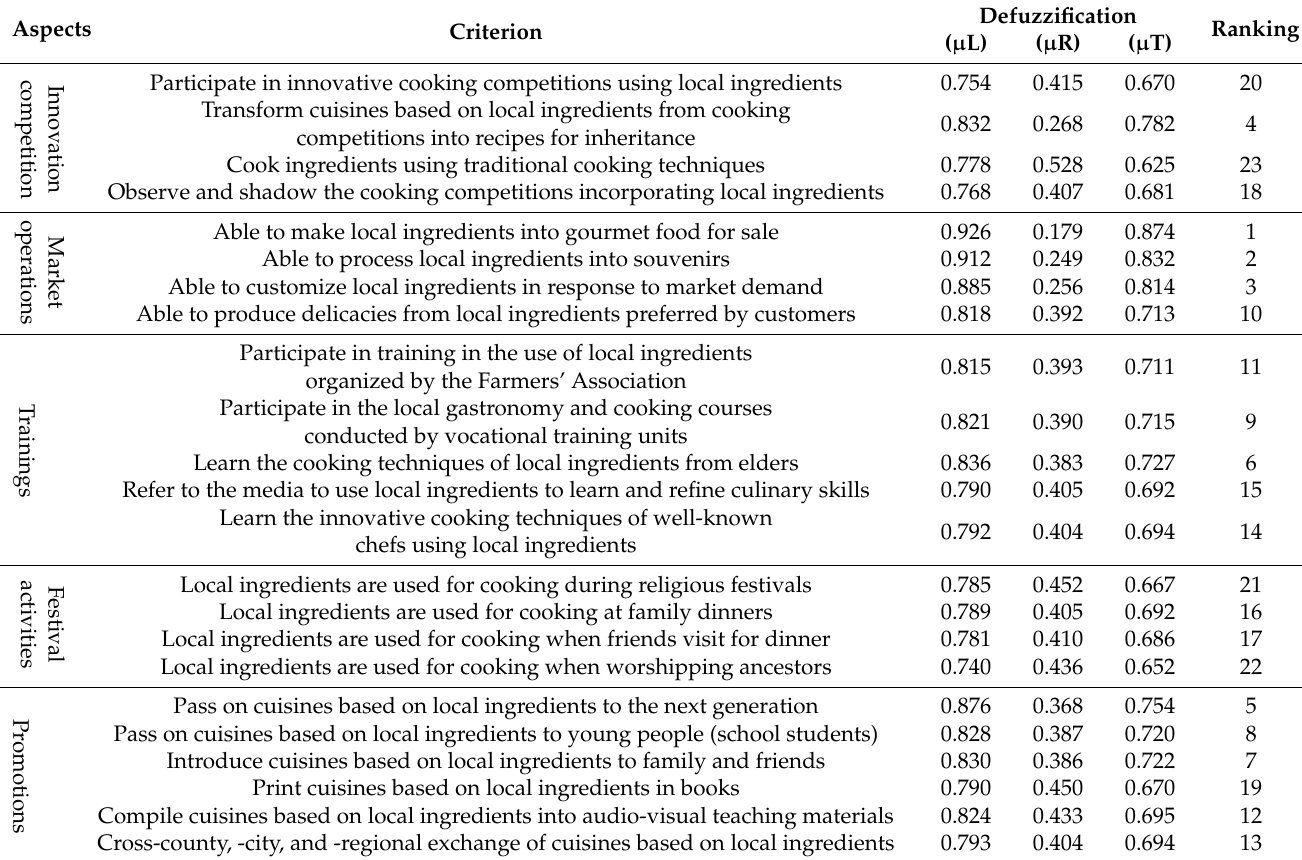
Table 4. Analysis table of defuzzification for the sustainable inheritance of rural cooking techniques and innovative business